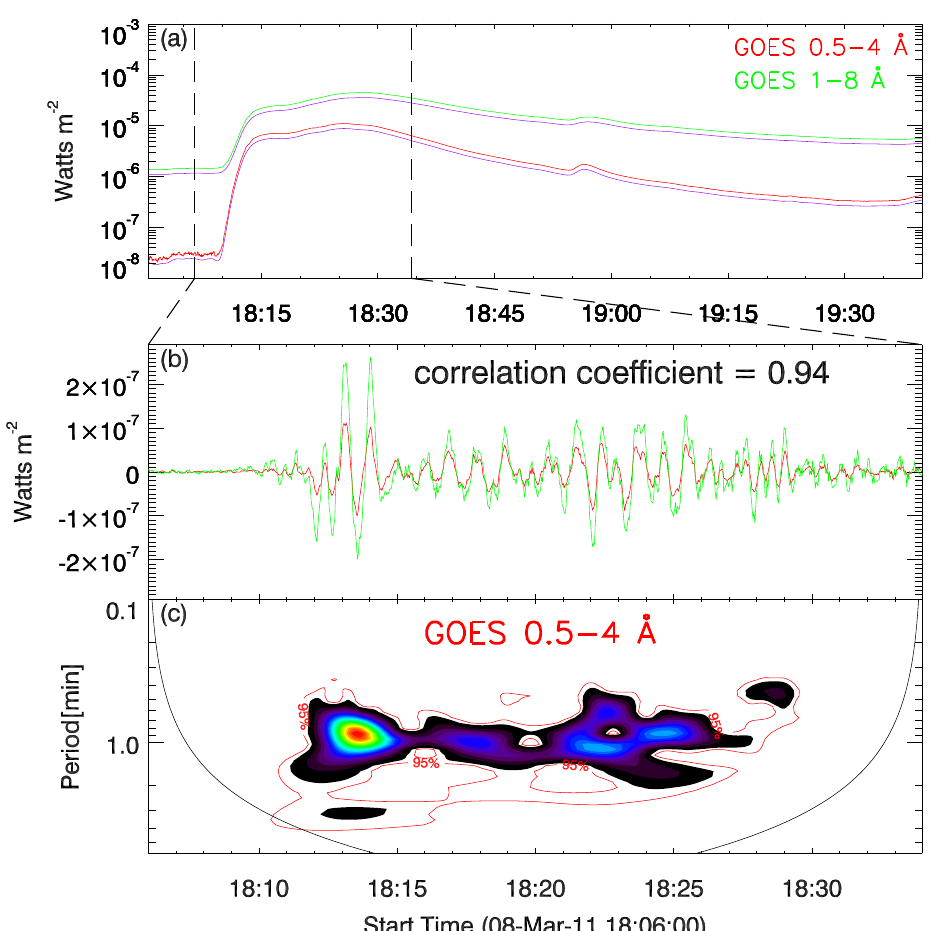
Figure 1. ( a ) The light curves of GOES 0.5–4 ˚A (red), and 1–8 ˚A (green), and their slowly-varying components (purple, already multiplied by 0.8) for the 8 March 2011 solar flare. ( b ) Fast-varying components in the interval between two vertical dotted lines, the correlation coefficient is given. ( c ) The wavelet spectrum of the fast-varying component at GOES 0.5–4 ˚A. The red contours represent a significance level of